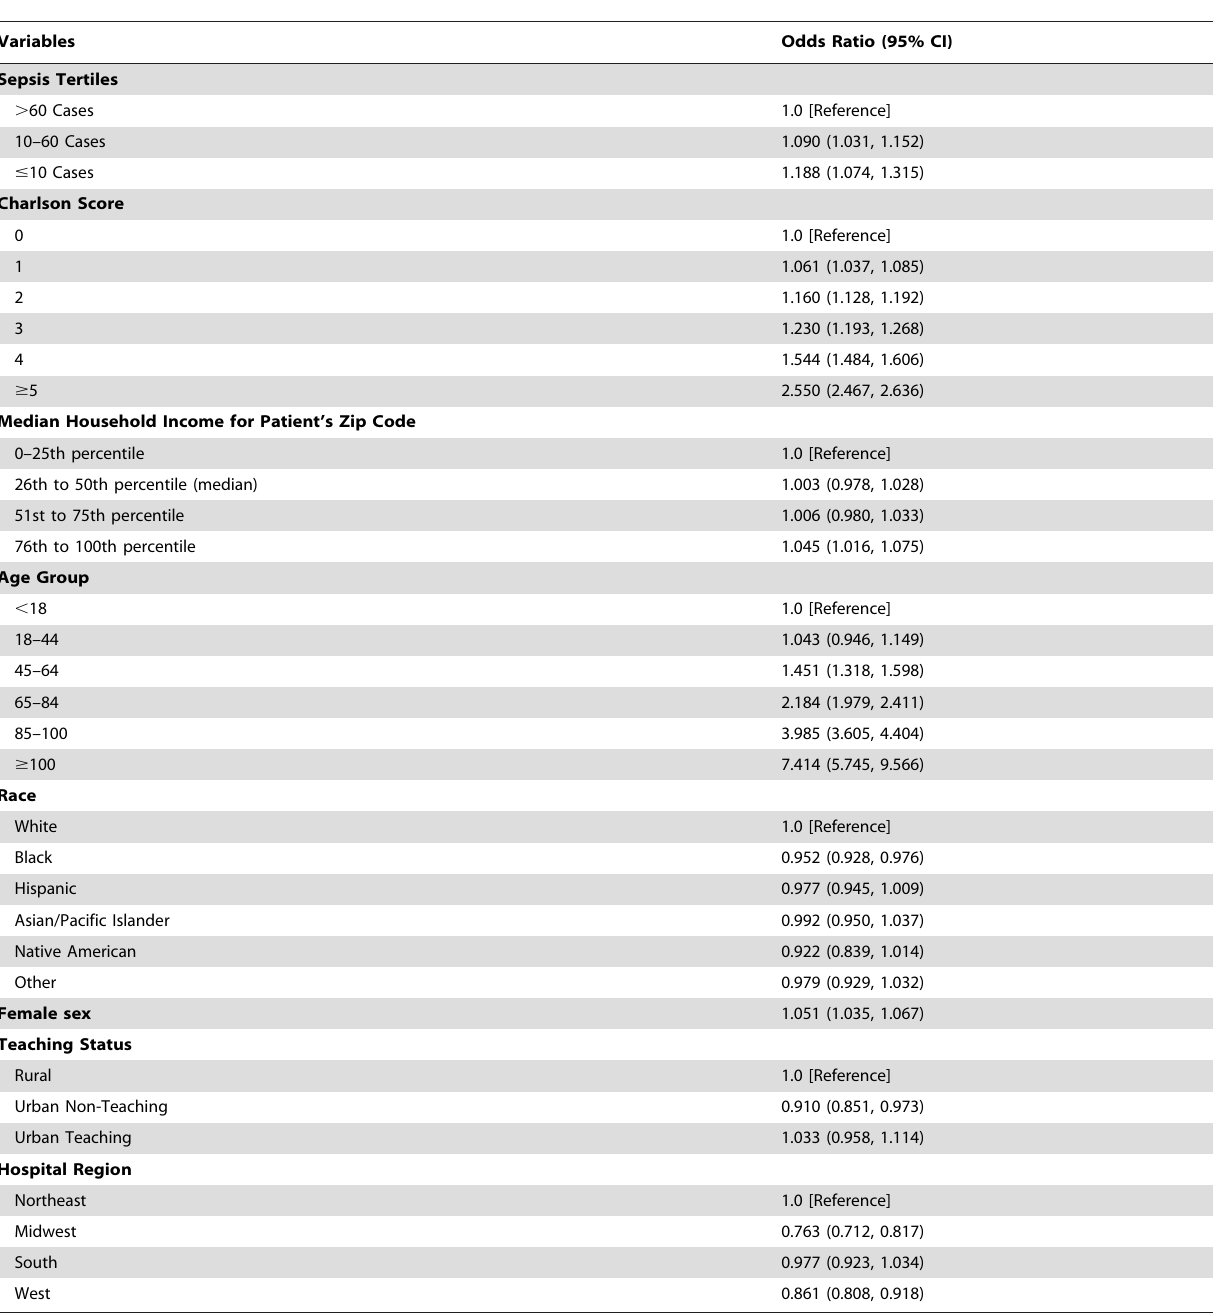
Table 4. Multivariate Model Adjusting for demographics and severity of illness.